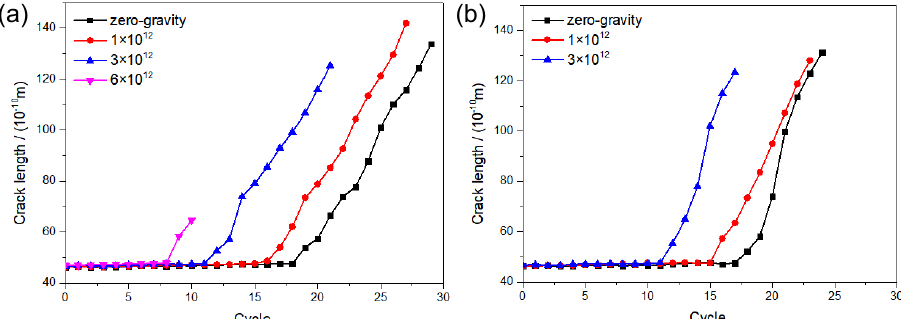
Figure 9. Crack length as a function of cycle number under different hyper-gravity intensities ( a ) 600 K and ( b ) 900 K.